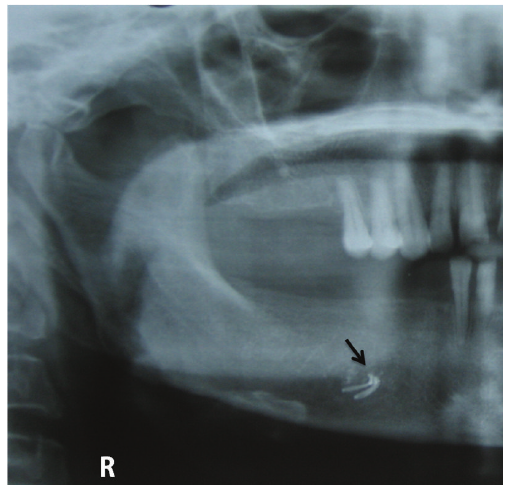
Figure 3: Part of the OPG showing the presence of radiopaque foreign body in the region of right mental foramen.